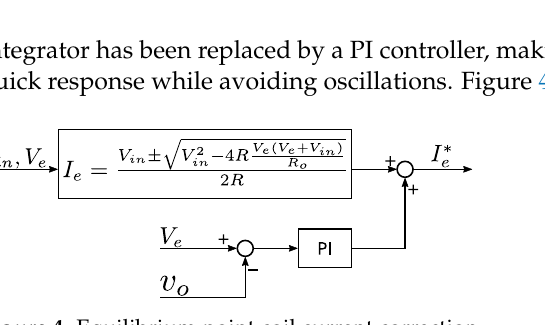
Figure 4. Equilibrium point coil current correction.